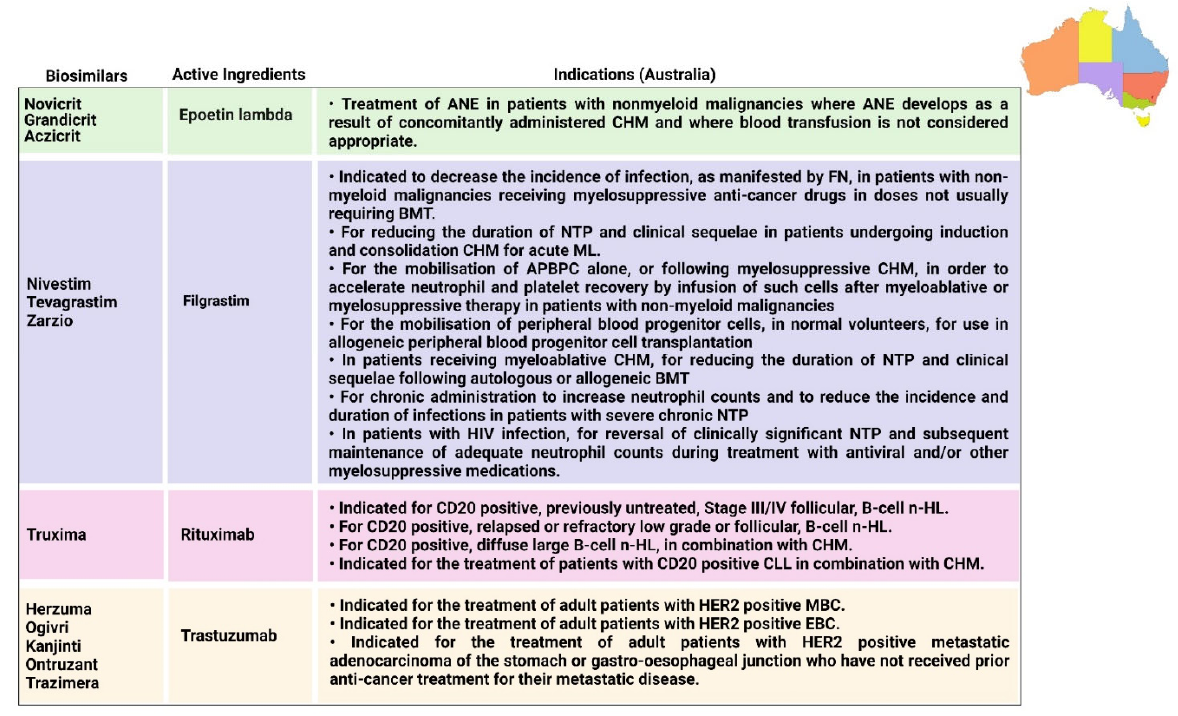
Figure 7. Indications approved in Australia for biosimilars [126,127,128,129,130,131] . ANE = anemia; BC = breast cancer; APBPC = autologous peripheral blood progenitor cell; B ‐ CLL = B ‐ cell chronic lymphocytic leukemia; BMT = bone marrow transplantation; CHM = chemotherapy; CLL = chronic lymphocytic leukemia; EBC = early breast cancer; FN = febrile neutropenia; HER2 = human epidermal growth factor receptor 2; ML = myeloid leukemia; MBC = metastatic breast cancer; n ‐ HL = non ‐ Hodgkin lymphoma; NTP = neutropenia.